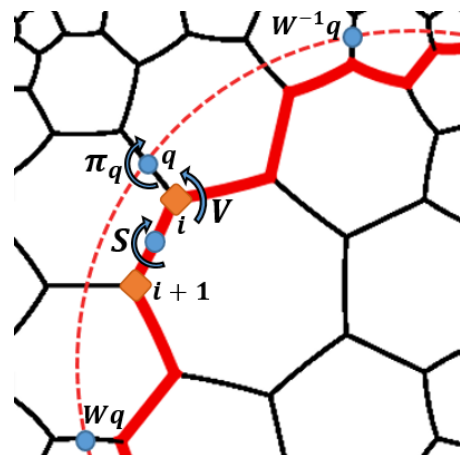
(cid:16) 0 1 0 (cid:17) in f 7 ; 3 g tiling, 1 0 1